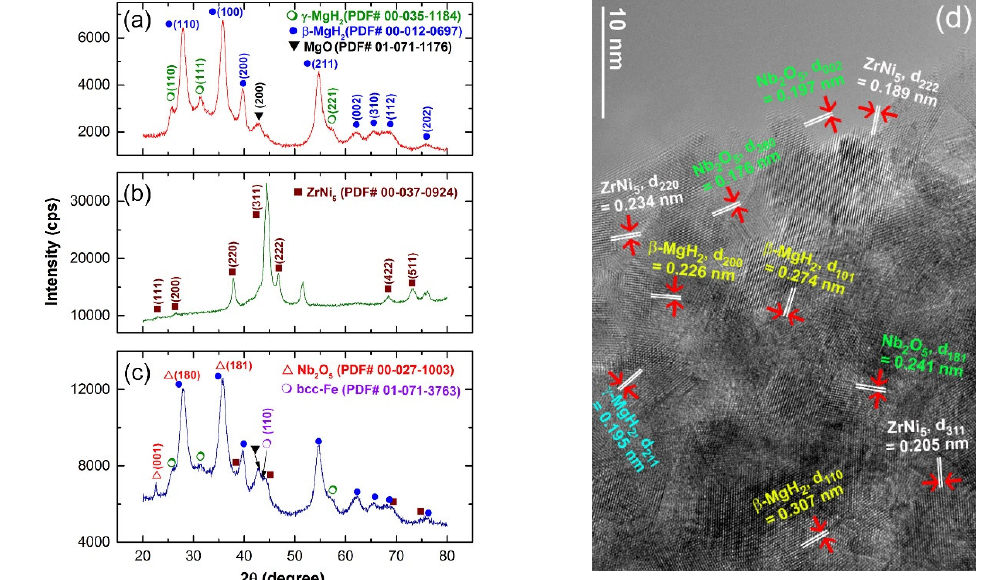
Figure 1. X-ray diffraction (XRD) patterns of ( a ) MgH 2 powders obtained after 200 h of reactive ball milling, ( b ) ZrNi 5 powders obtained after 10 h of high energy ball milling and ( c ) nanocomposite MgH 2 doped with 5 wt% (2.5 ZrNi 5 /2.5 Nb 2 O 5 ) powders after milling for 50 h. The powders were contaminated with 1.36 wt% Fe, which came from using stainless steel milling tools, as indicated by Bragg peak of Fe(110) shown in ( c ). The FE-HRTEM micrograph of nanocomposite powders obtained after 50 h of milling is displayed in ( d ).